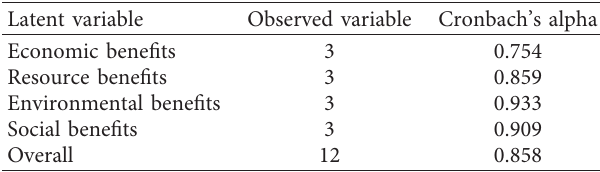
Table 3: Reliability test